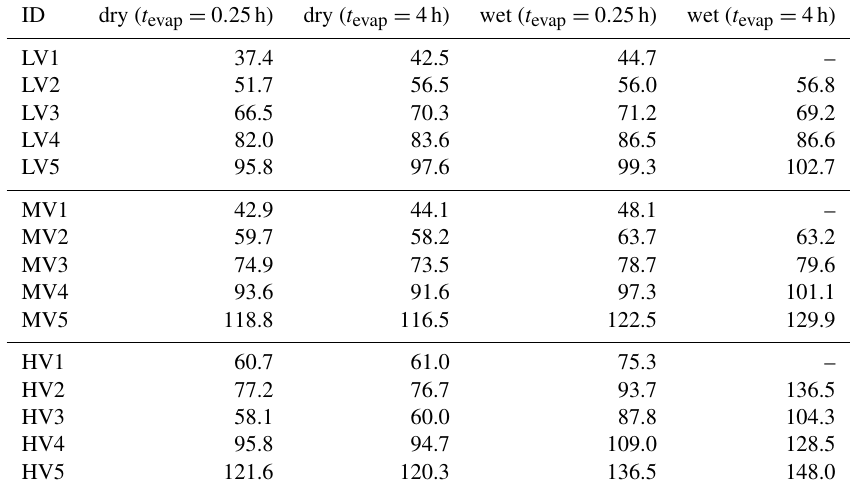
Table 2. T max values for all type-V factors. The “–” symbol indicates that there was not enough signal to determine the T max value.